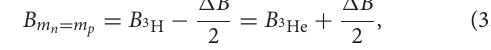
m p , N max 16, and γ 4 fm − 1 , as function of j max and = = =